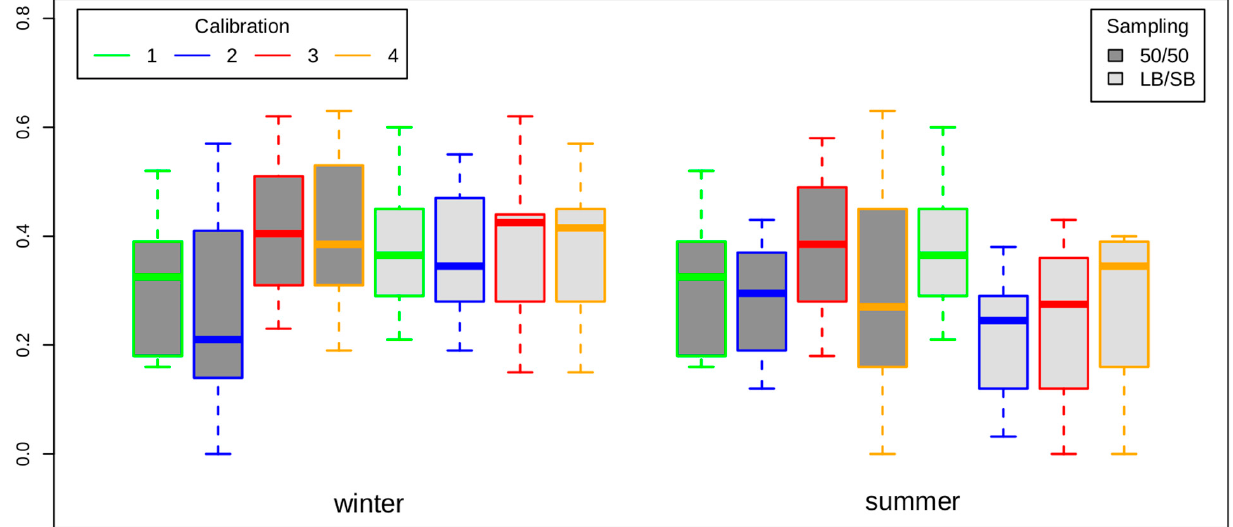
Figure 5. Distribution of R-squared between S 0 /A parameter and basin descriptors, for the two seasons and the two samplings.